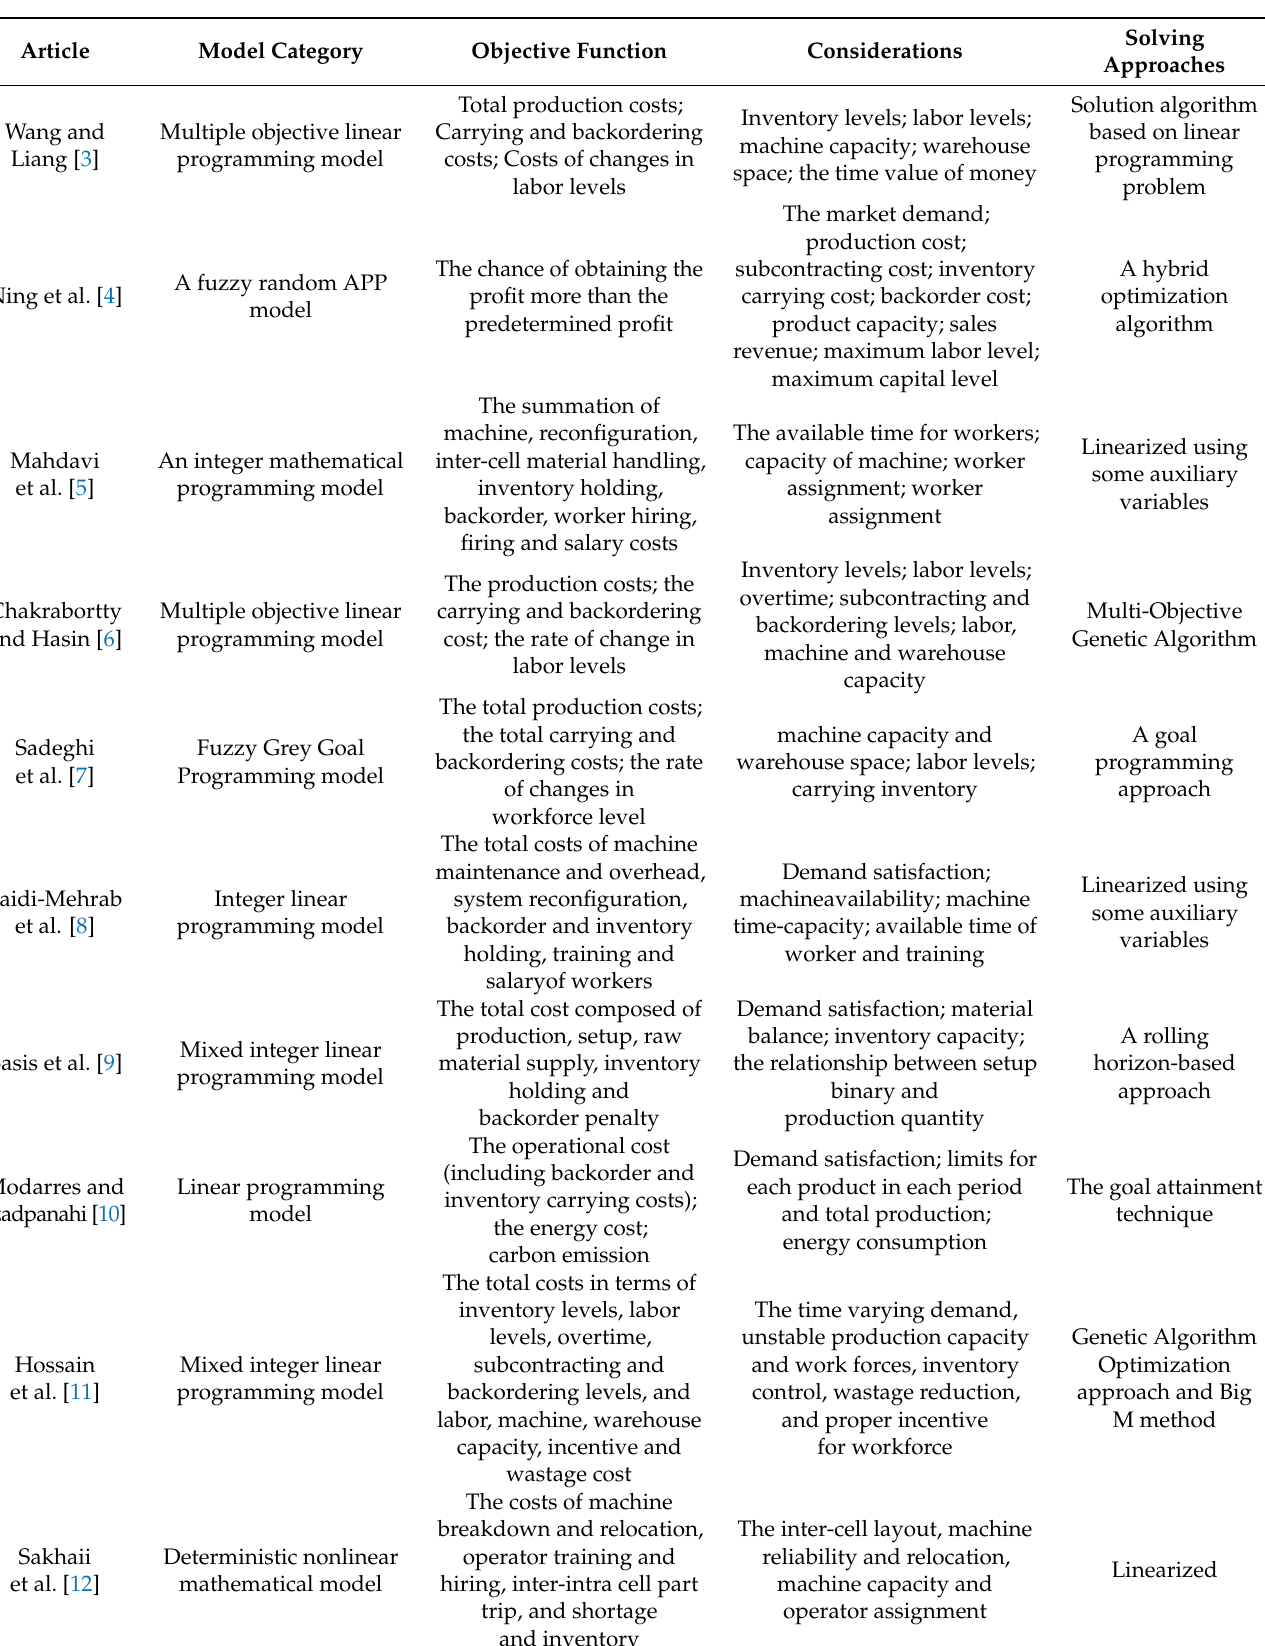
Table 1. The related studies considering the backordering for